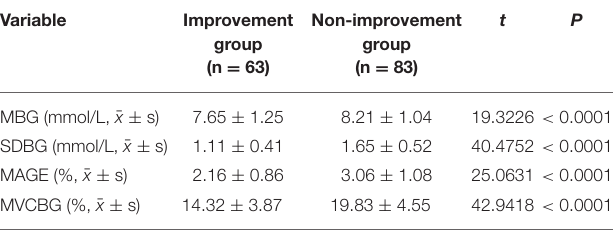
TABLE 2 | Comparison of blood glucose monitoring indexes.